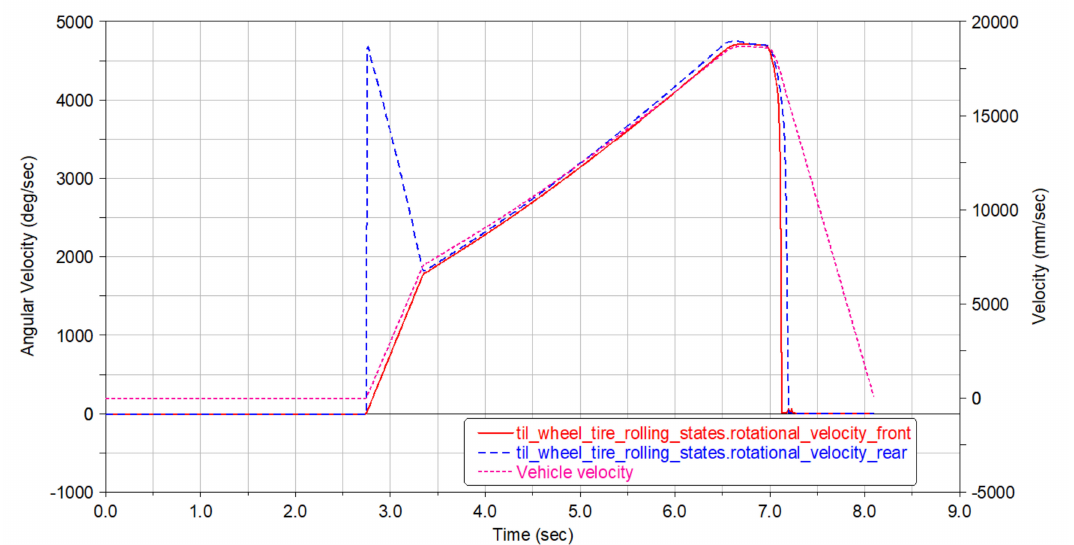
Figure 11. Brake Test-Optimized